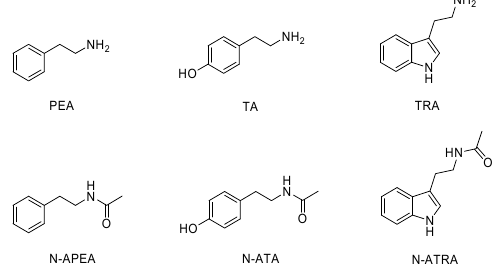
Figure 1. Structures of phenethylamine (PEA), tyramine (TA), and tryptamine (TRA) and their N -acetyl derivatives, N-acetylphenethylamine (N-APEA), N-acetyltyramine (N-ATA), and N-acetyltryptamine (N-ATRA).